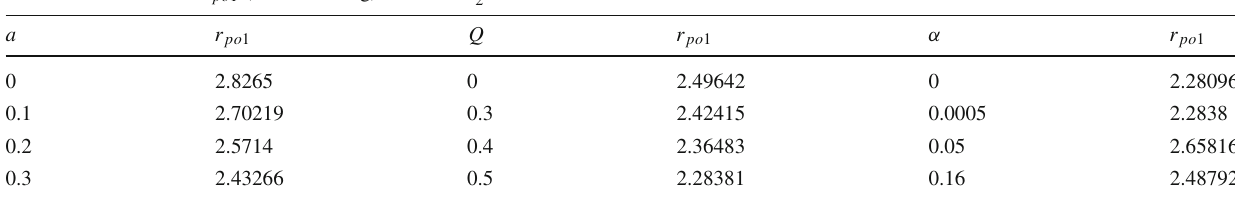
Table 3 Photon orbits r po 1 (direct rotating) for ω = − 1